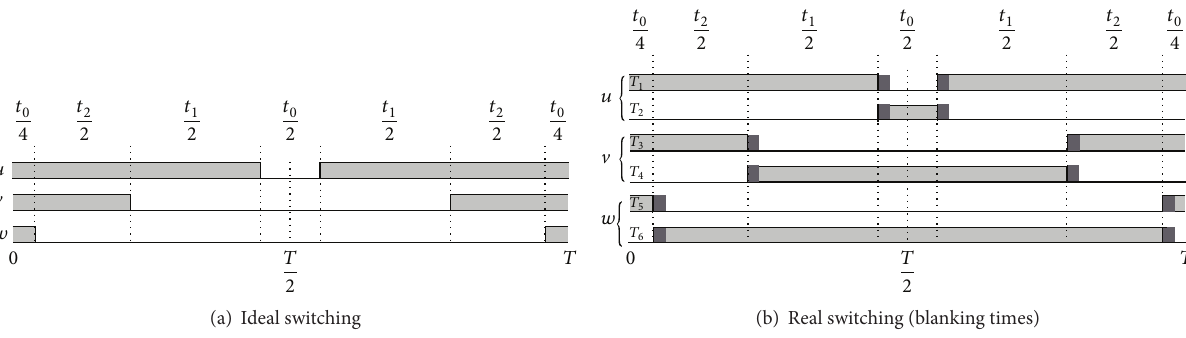
Figure 16: Switching state and effects of blanking